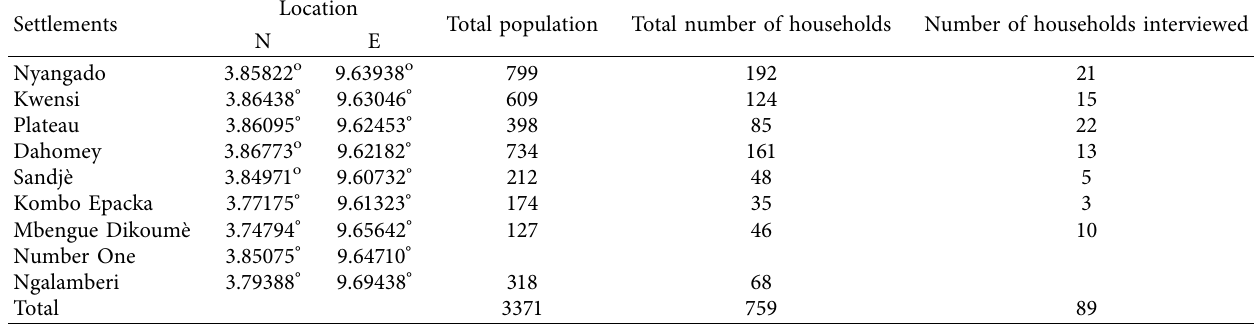
Table 4: Number of household members sampled per village.